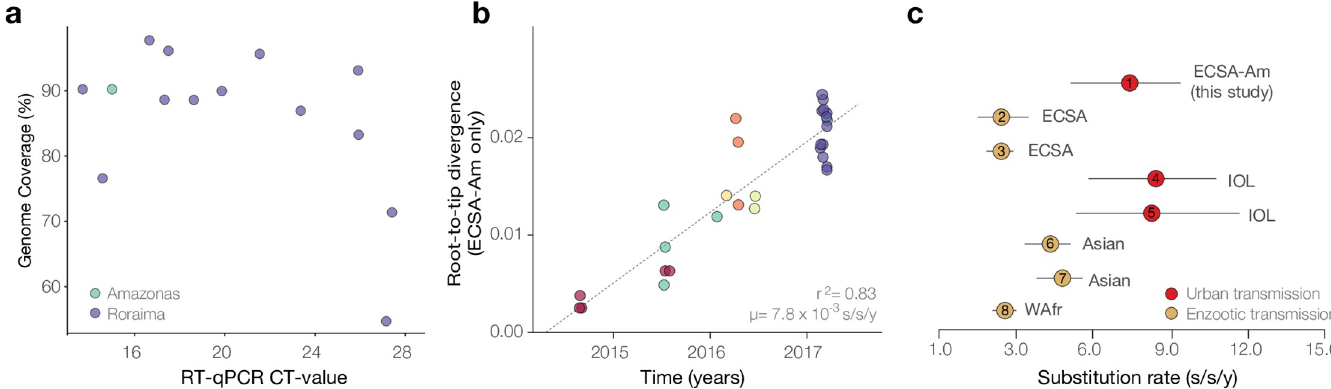
Fig 2. Sequencing statistics, temporal signal and evolutionary rates of the CHIKV-ECSA lineage. A. Genome coverage plotted against RT-qPCR CT-values for the newly generated sequence data. B. Genetic divergence regressed against dates of sample collection for dataset 2 (CHIKV-ECSA-Br lineage). C. Evolutionary rate estimates for the CHIKV-ECSA-Br lineage obtained by this study (circle number 1) compared to published evolutionary rates obtained for other lineages. Circles numbered 2 to 8 represent point estimates reported in [1, 9, 80]. Horizontal bars represent 95% highest posterior density credible intervals for evolutionary